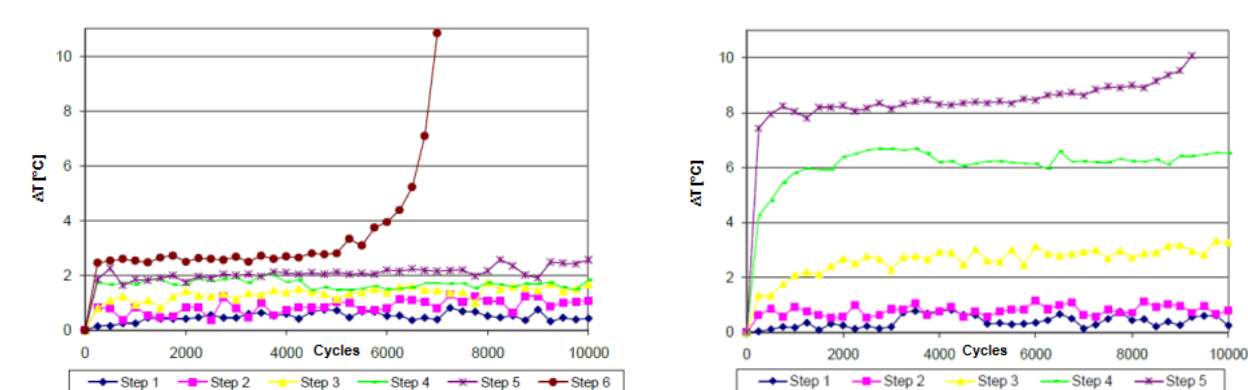
Figure 17: Thermal map of the specimen 5. Figure 18: Thermal map of the specimen 6.